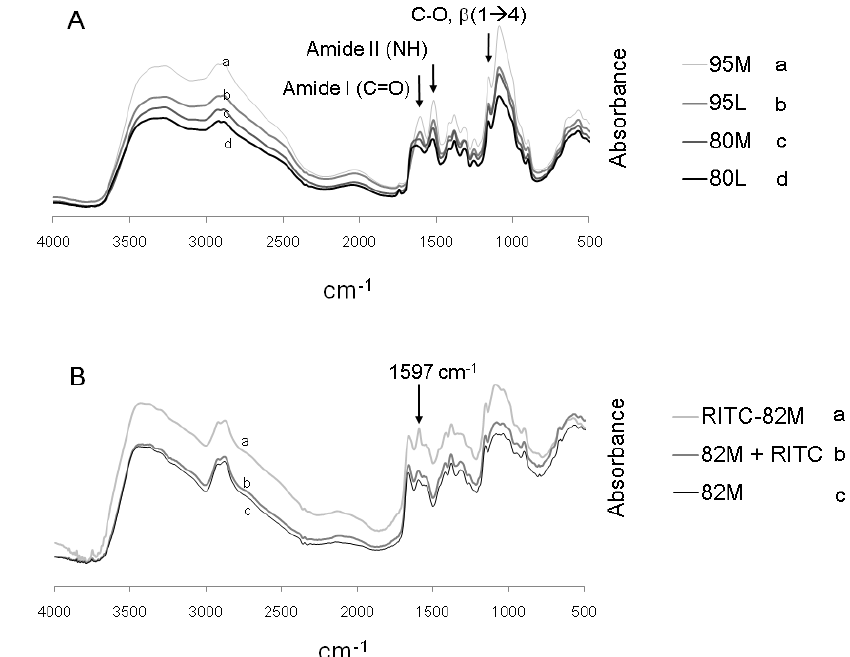
Figure 3. FT-IR spectra of the chitosan library prior to RITC coupling ( A ), and RITC-82M chitosan vs. 82M chitosan-only and 82M chitosan mixed with RITC without coupling ( B ). Chitosans were analyzed in the HCl salt conjugate form ( A ) or free base form ( B